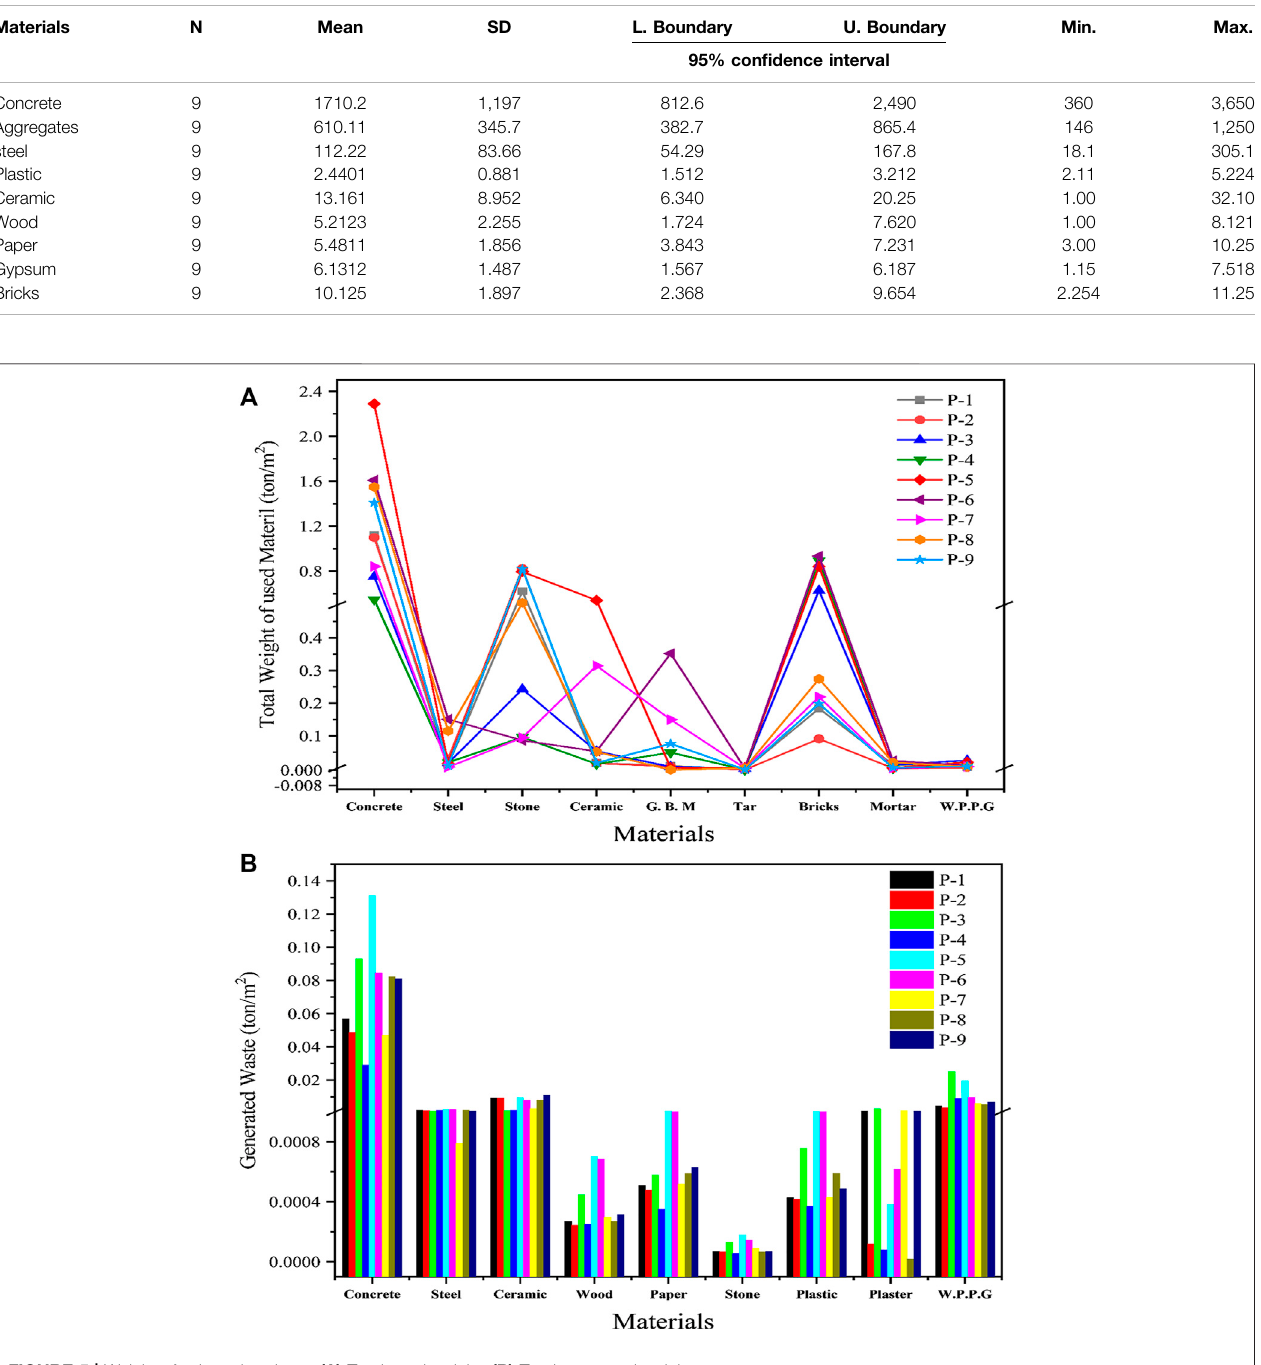
Frontiers in Environmental Science |